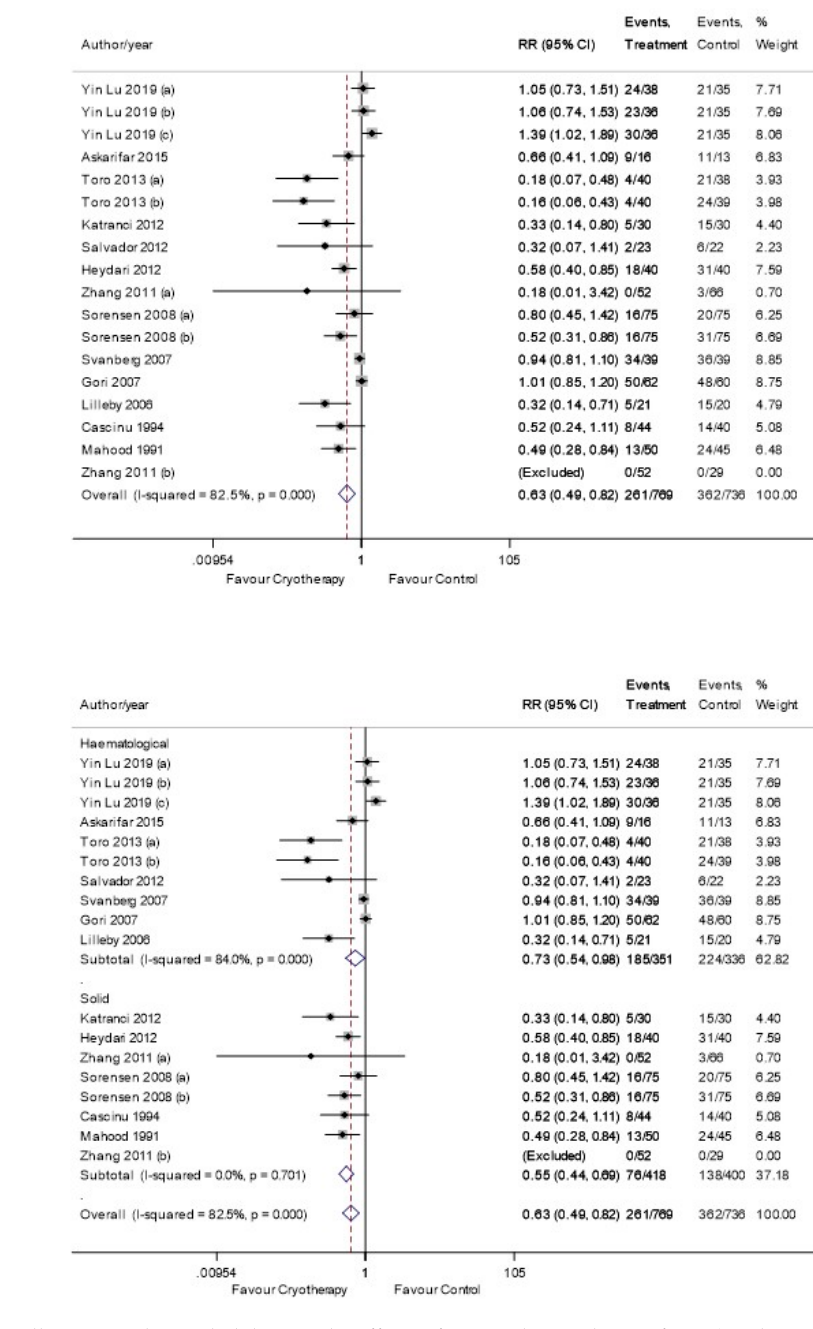
Figure 3. ( a ) Forest plot illustrating the pooled data on the effects of OC on the incidence of OM (moderate-severe). ( b ) Forest plot illustrating subgroup analysis of the effects of OC on the incidence of moderate-severe OM based on the underlying malignancy.